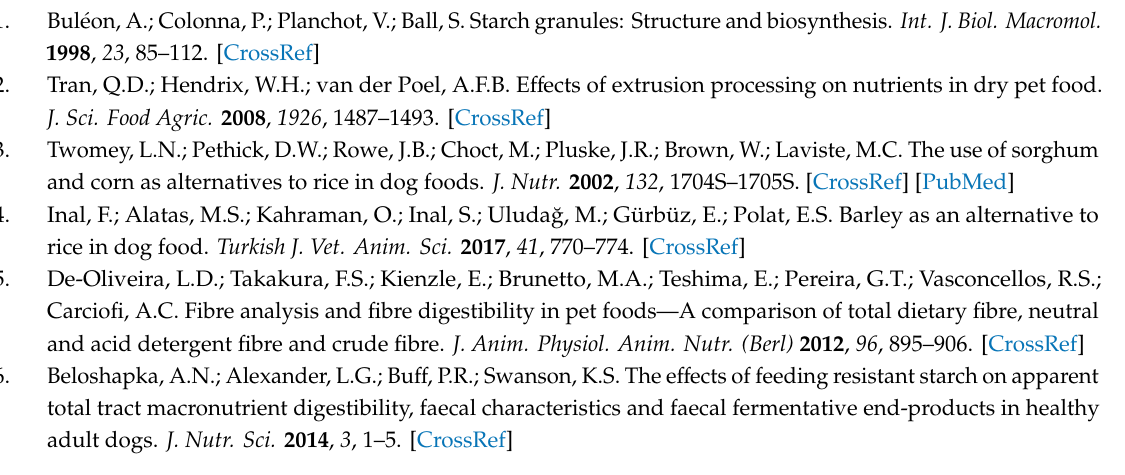
Table S1. List of ingredients for each sample as declared by the manufacturer on the label of the product. Table S2. Chemical composition of each sample as declared by the manufacturer on the label of the